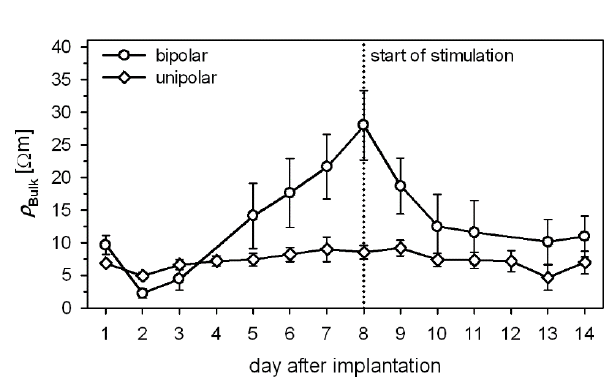
Figure 8: In vivo time courses of the effective specific resistivities of the brain tissue that surrounded four bipolar and nine unipolar electrodes (mean values ± SEM). The vertical dotted line indicates the DBS initiation.